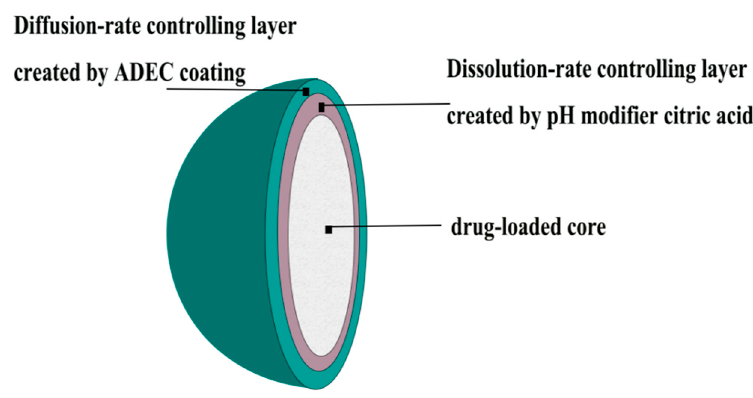
Figure 1. Schematic diagram of the sustained release pellets.